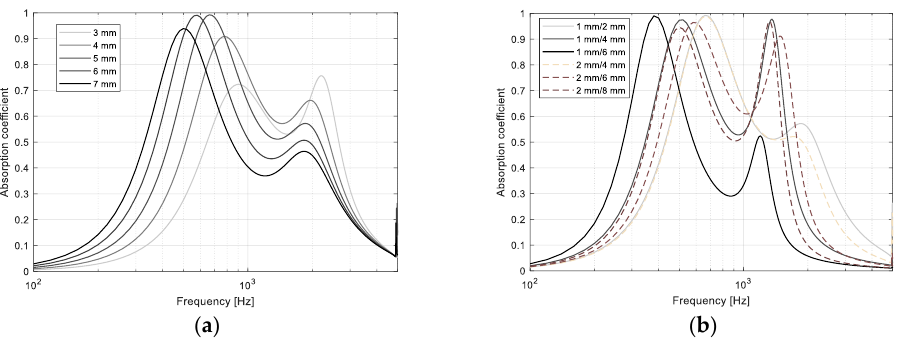
Figure 9. Sound absorption coefficient of a double layer PP-MPM panel for different parameter modifications: ( a ) distance between holes of the innermost layer (microperforated); and, ( b ) hole diameter and distance between holes of the outermost layer.